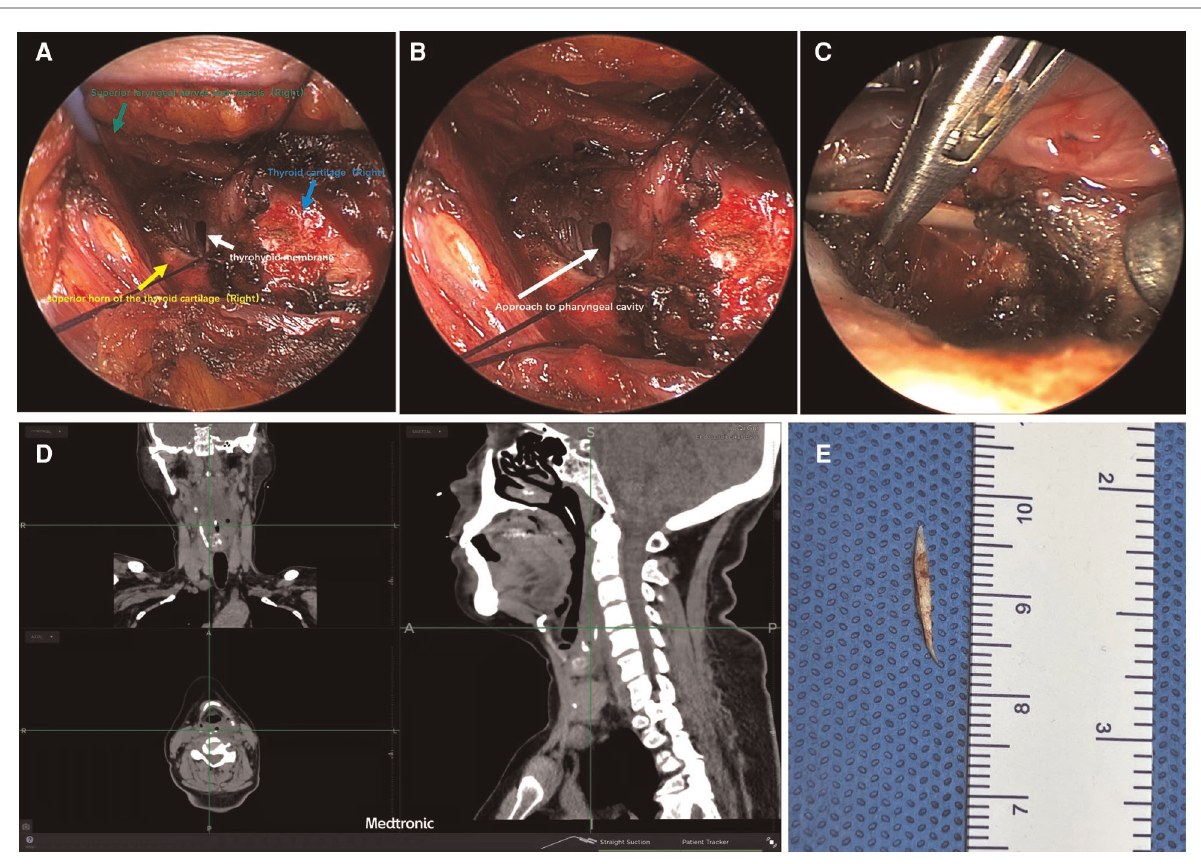
FIGURE 3 Representative images of transcervical surgery with the combined use of both endoscope and image guidance navigation. ( A ) Exposure of the thyroid cartilage, thyrohyoid membrane, superior horn of the thyroid cartilage, and superior laryngeal nerves; ( B ) incision of a thyrohyoid membrane involved making an opening to the pharyngeal cavity; ( C ) successful location and retrieval of a foreign body from retropharyngeal space; ( D ) intraoperative positioning of the foreign body using image guidance navigation; ( E ) image of the foreign